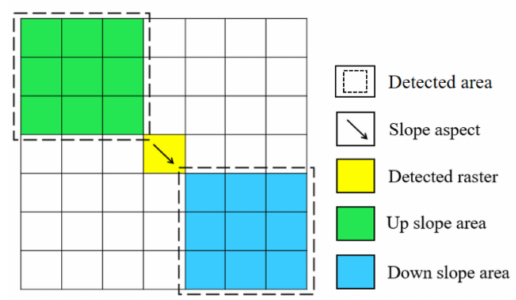
Figure 9. Analysis operator (size 7 ∗ 7